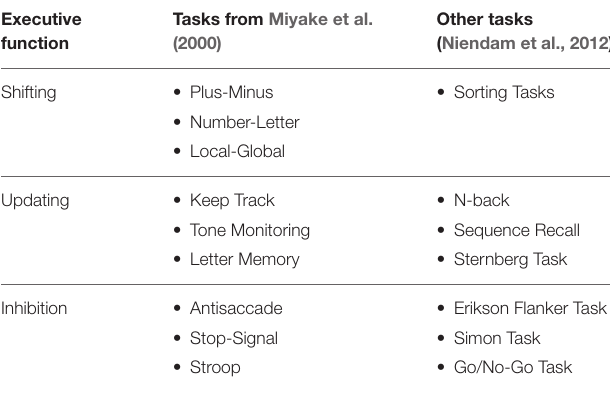
TABLE 1 | Summary of simple cognitive tasks used to investigate individual executive functions. Executive